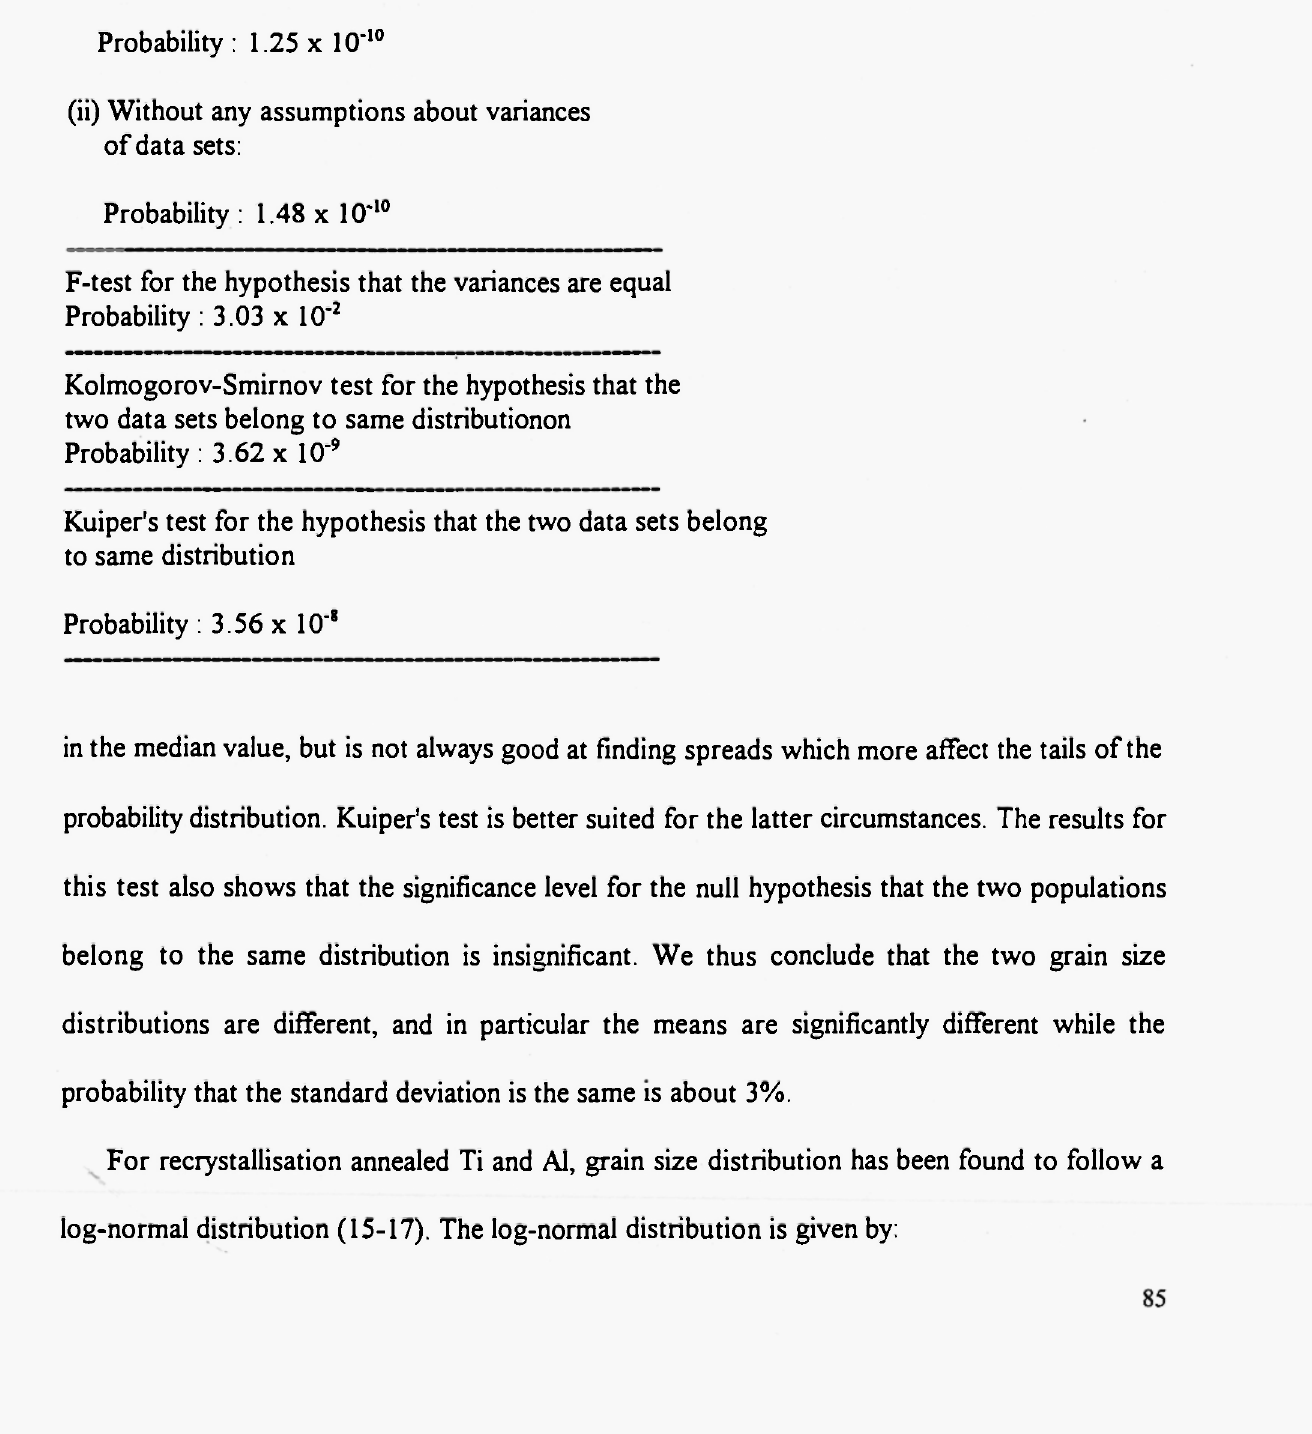
Student's t-test for the hypothesis that the means are equal (i) Assuming data sets to be drawn from